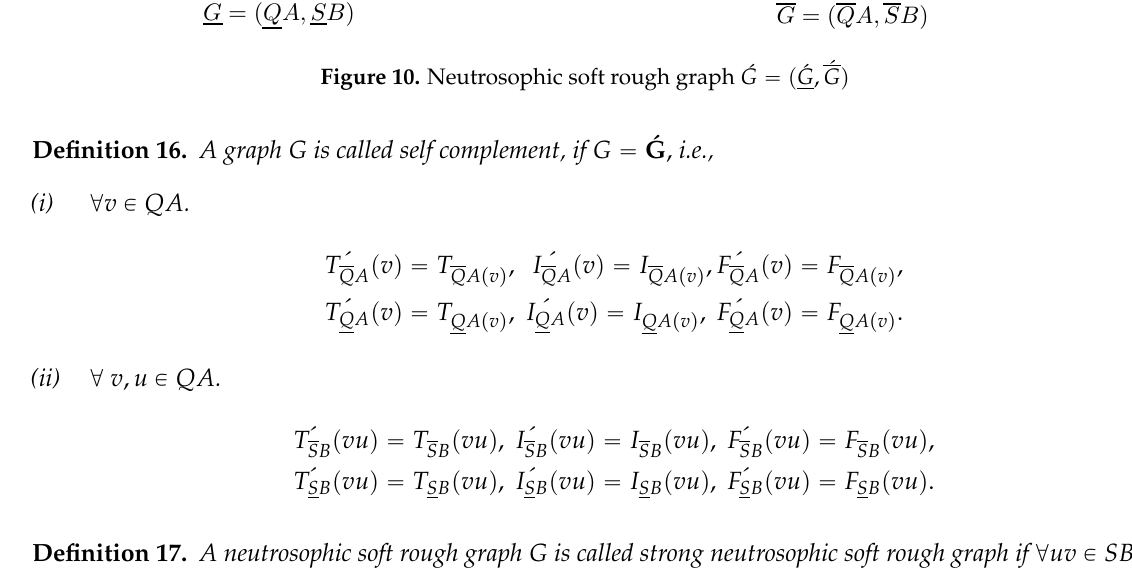
´ G ) Figure 10. Neutrosophic soft rough graph